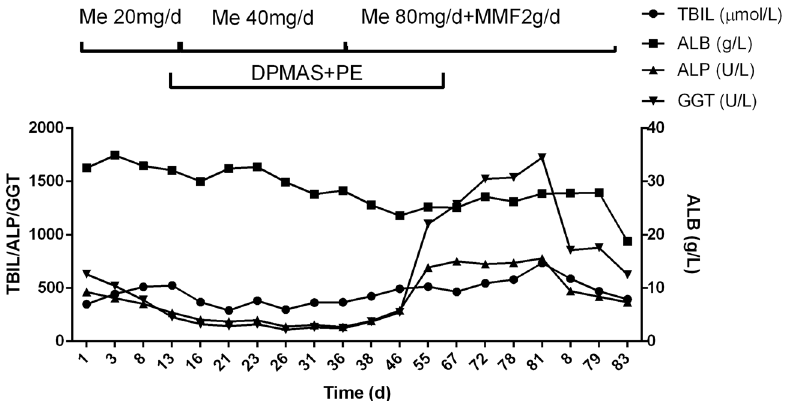
Figure 1: Liver function changes and treatment fl ow